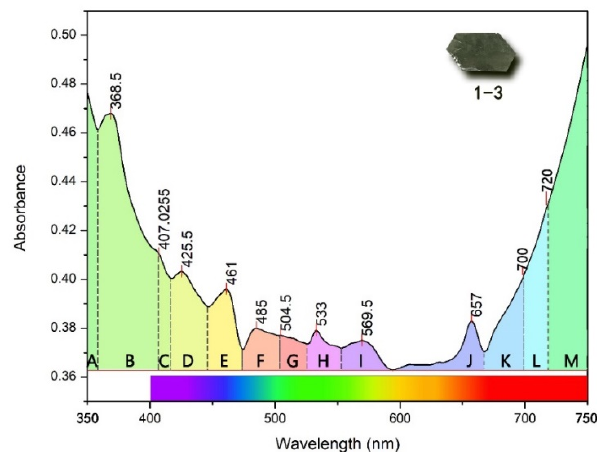
Figure 9. UV–vis absorption spectrum of sample no. 1–3; the letters represent different blocks of absorption peaks.